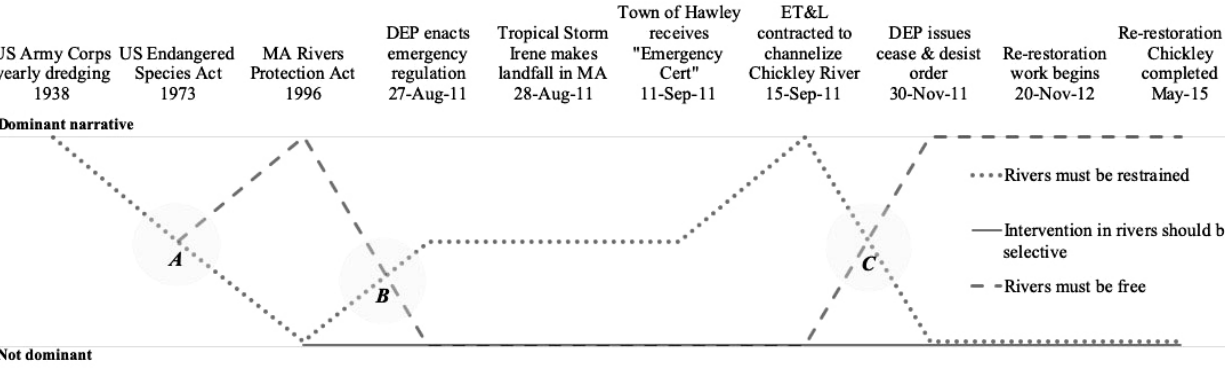
Fig. 4 . Evolution of narrative dominance in Chickley River governance (Not to scale). (A) Represents the transformation from restraining rivers to freeing them, 1938–1996; (B) represents a return to river restraint, 2011; (C) represents the return to a free river, political crisis, and a polarized community, 2011–2018. Although not depicted because of the two-dimensional limitations of this figure, each of the three narratives coevolve at each transformation as described in the narrative descriptions presented in the text. MA, Massachusetts; DEP, Massachusetts Department of Environmental